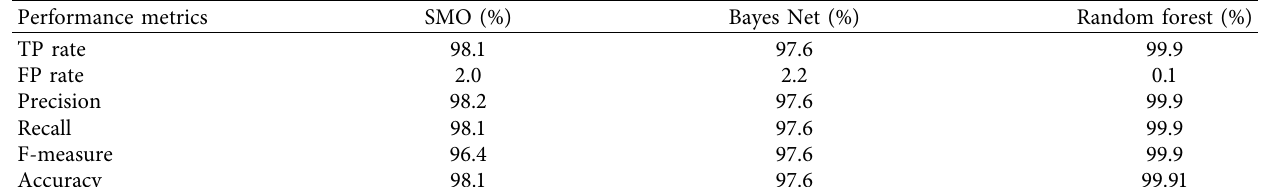
Table 2: Performance comparison of algorithms with different evaluation metrics.